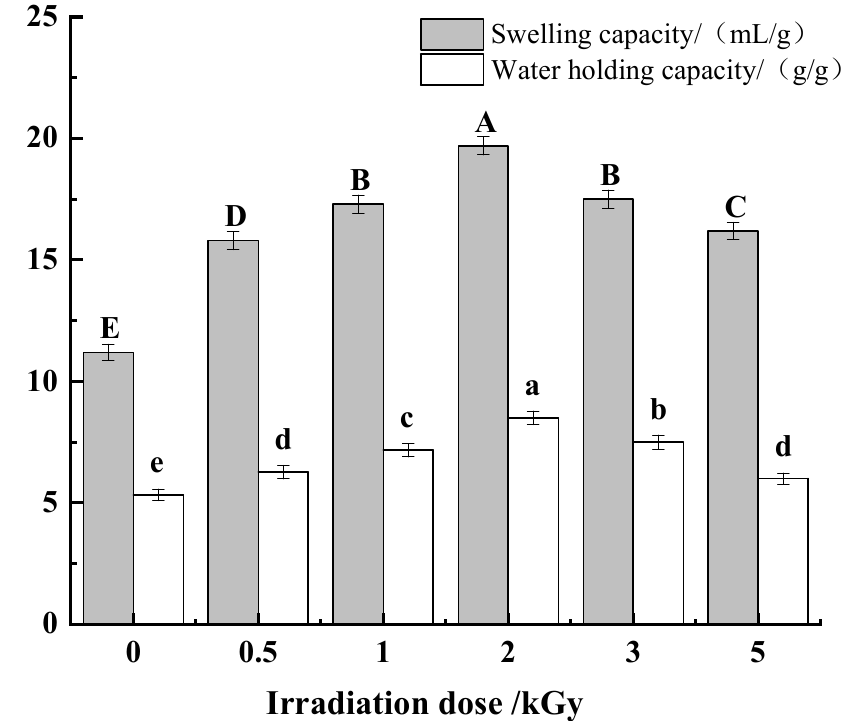
Figure 5. Effects of γ -irradiation on the swelling and water-holding capacity of pea fiber. Note: Different uppercase letters indicate significant differences in swelling capacity ( p < 0.05), and different lowercase letters indicate significant differences in water-holding capacity ( p < 0.05).